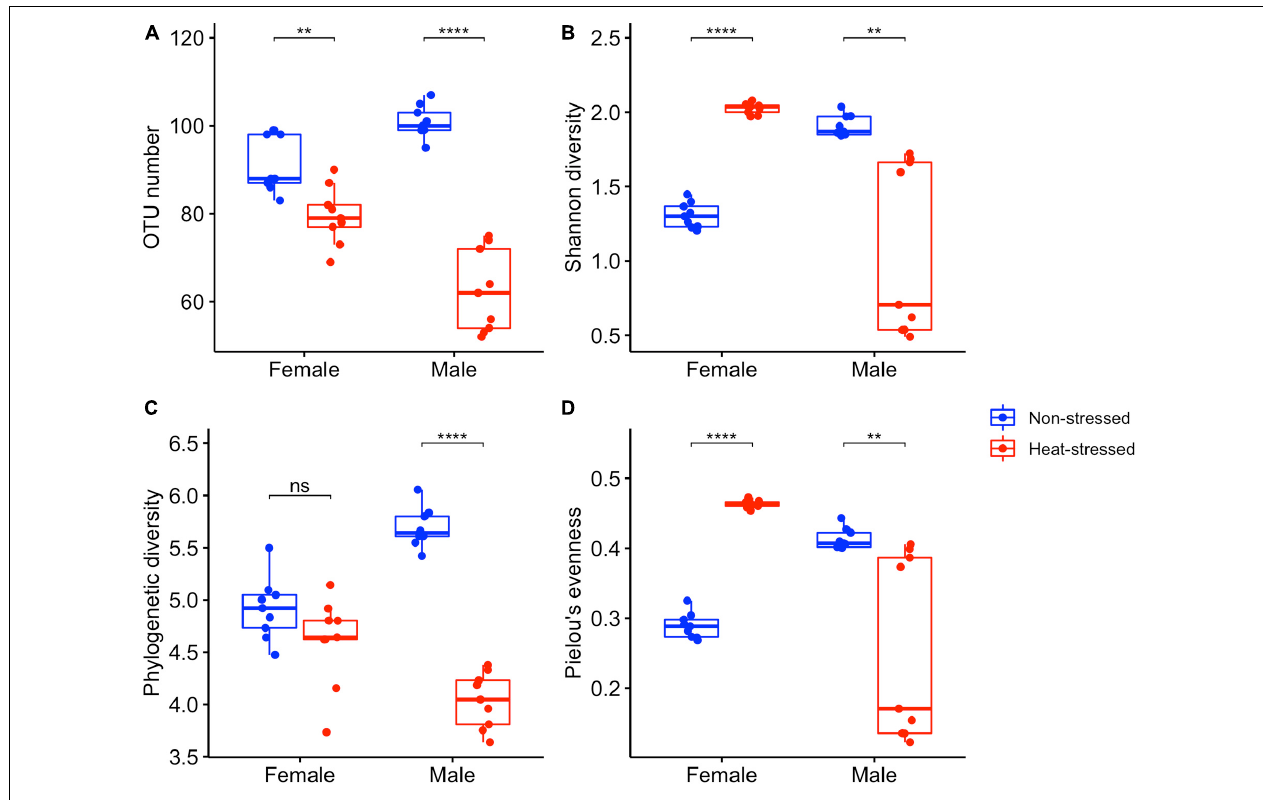
FIGURE 4 | Bacterial diversity indices estimated for the gut microbiota of Drosophila subobscura : (A) richness (OTU number), (B) Shannon’s diversity, (C) phylogenetic diversity (Faith’s index), and (D) Pielou’s evenness. Flies of each sex were grouped into non-stressed (exposed to 21 ◦ C) and heat-stressed (exposed to 34 ◦ C) flies. Box plots show the median and interquartile range (IQR) and whiskers represent the 1.5*IQR. Symbols above box plots denote non-significant (ns) or significant differences between the non-stressed and heat-stressed flies obtained from linear models (** P < 0.01; **** P <